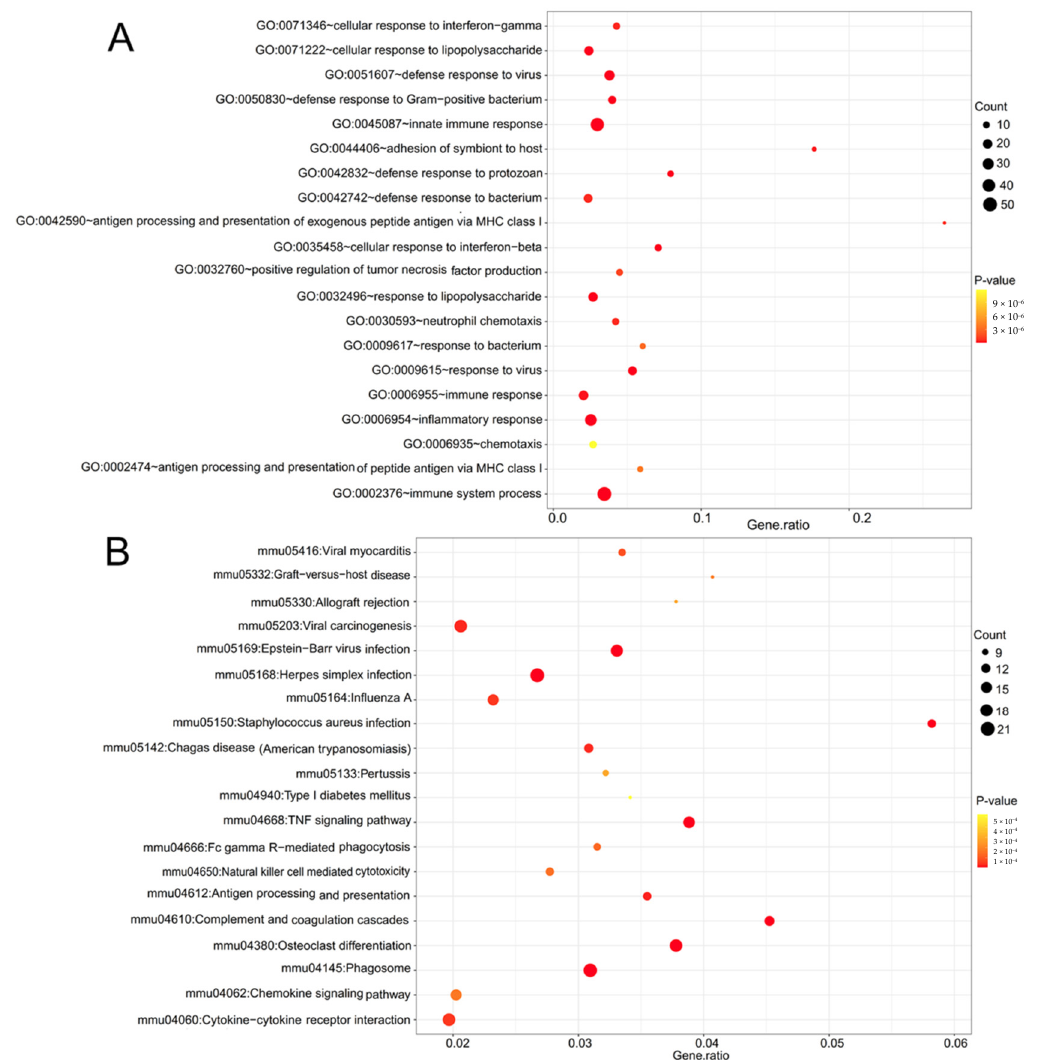
Figure 3. Function enrichment for the overlapped differentially expressed mRNAs between GSE49048- GSE49371 and GSE55228-GSE120257-GSE131486 datasets. ( A ) GO term; ( B ) KEGG pathways. Only top 20 are shown. GO: Gene Ontology; KEGG: Kyoto Encyclopedia of Genes and